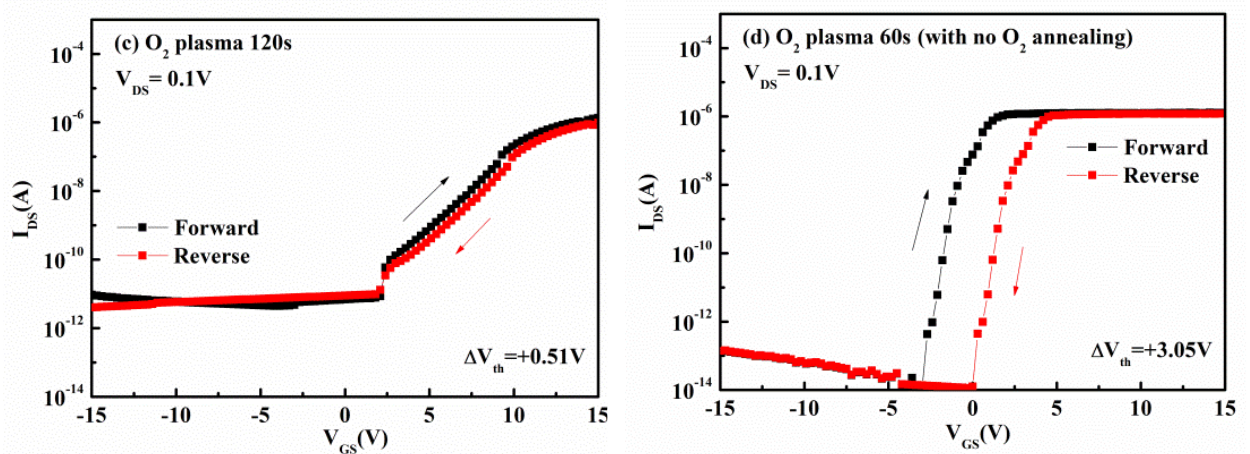
Figure 7. Hysteresis curves of IGZO TFTs at the O 2 plasma times of ( a ) 0, ( b ) 60, and ( c ) 120 s; ( d ) O 2 plasma time of 60 s, without O 2 annealing.